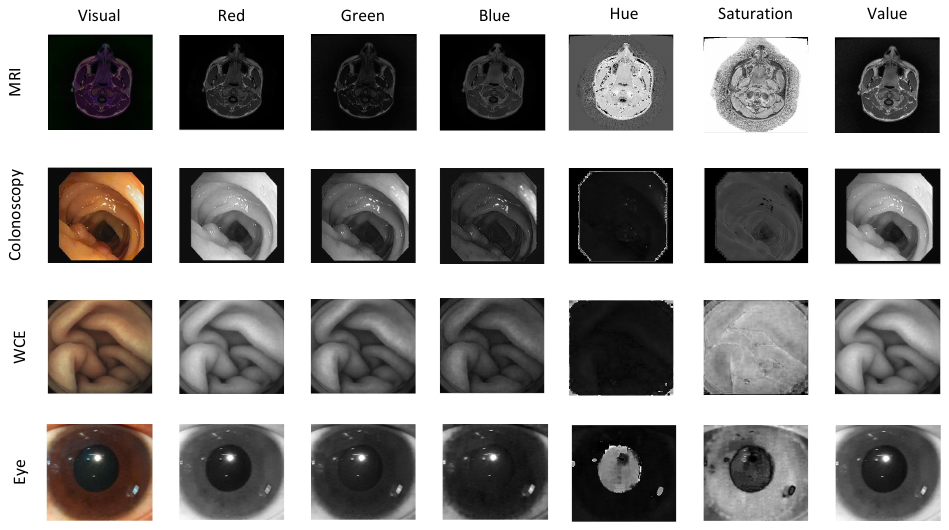
Figure 1. A comparison of the visual representation between RGB and HSV in medical